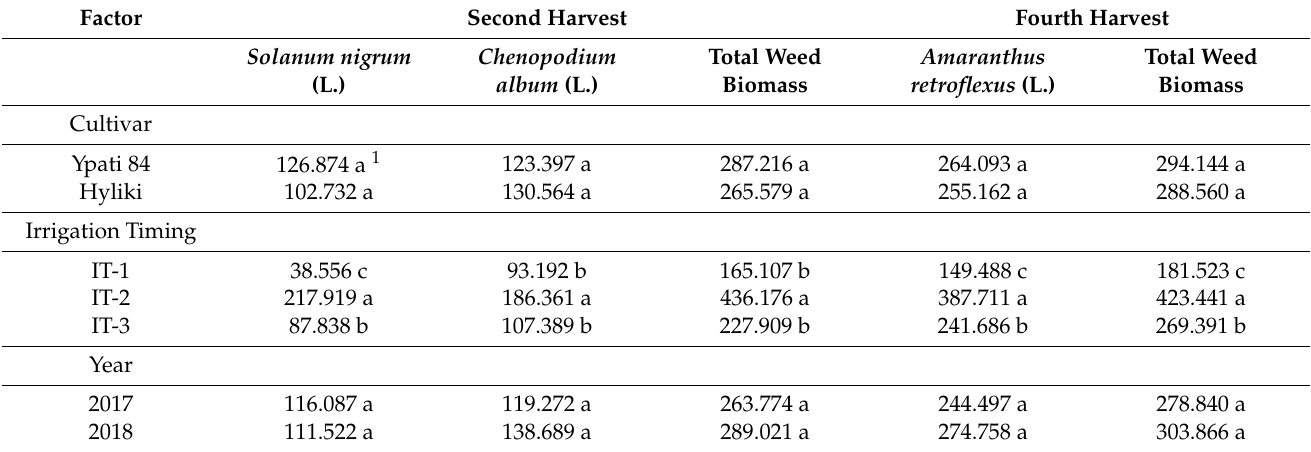
Table 6. The weed biomass (g · m − 2 ) values recorded, in the second and the fourth harvest, across the two experimental years. Solanum nigrum and Chenopodium album L. were the dominant species during the second harvest. Amaranthus retroflexus L. was the dominant species during the fourth